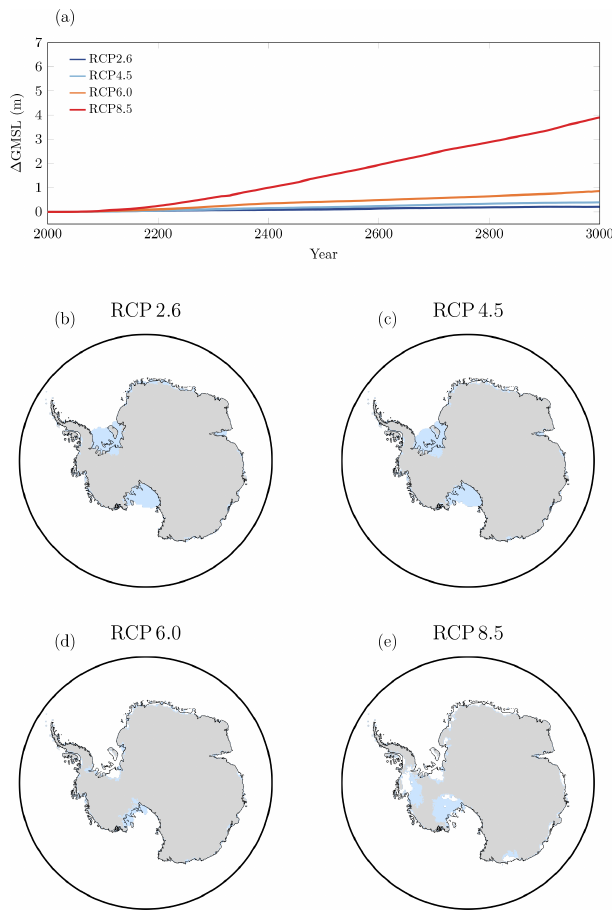
Figure 3. (a) Nominal AIS contribution to sea level. Grounded ice (grey area) and ice shelves (light blue area) by 3000 in (b) RCP 2.6, (c) RCP 4.5, (d) RCP 6.0 and (e) RCP 8.5 for the nominal values of the parameters. The present-day grounding line is shown in